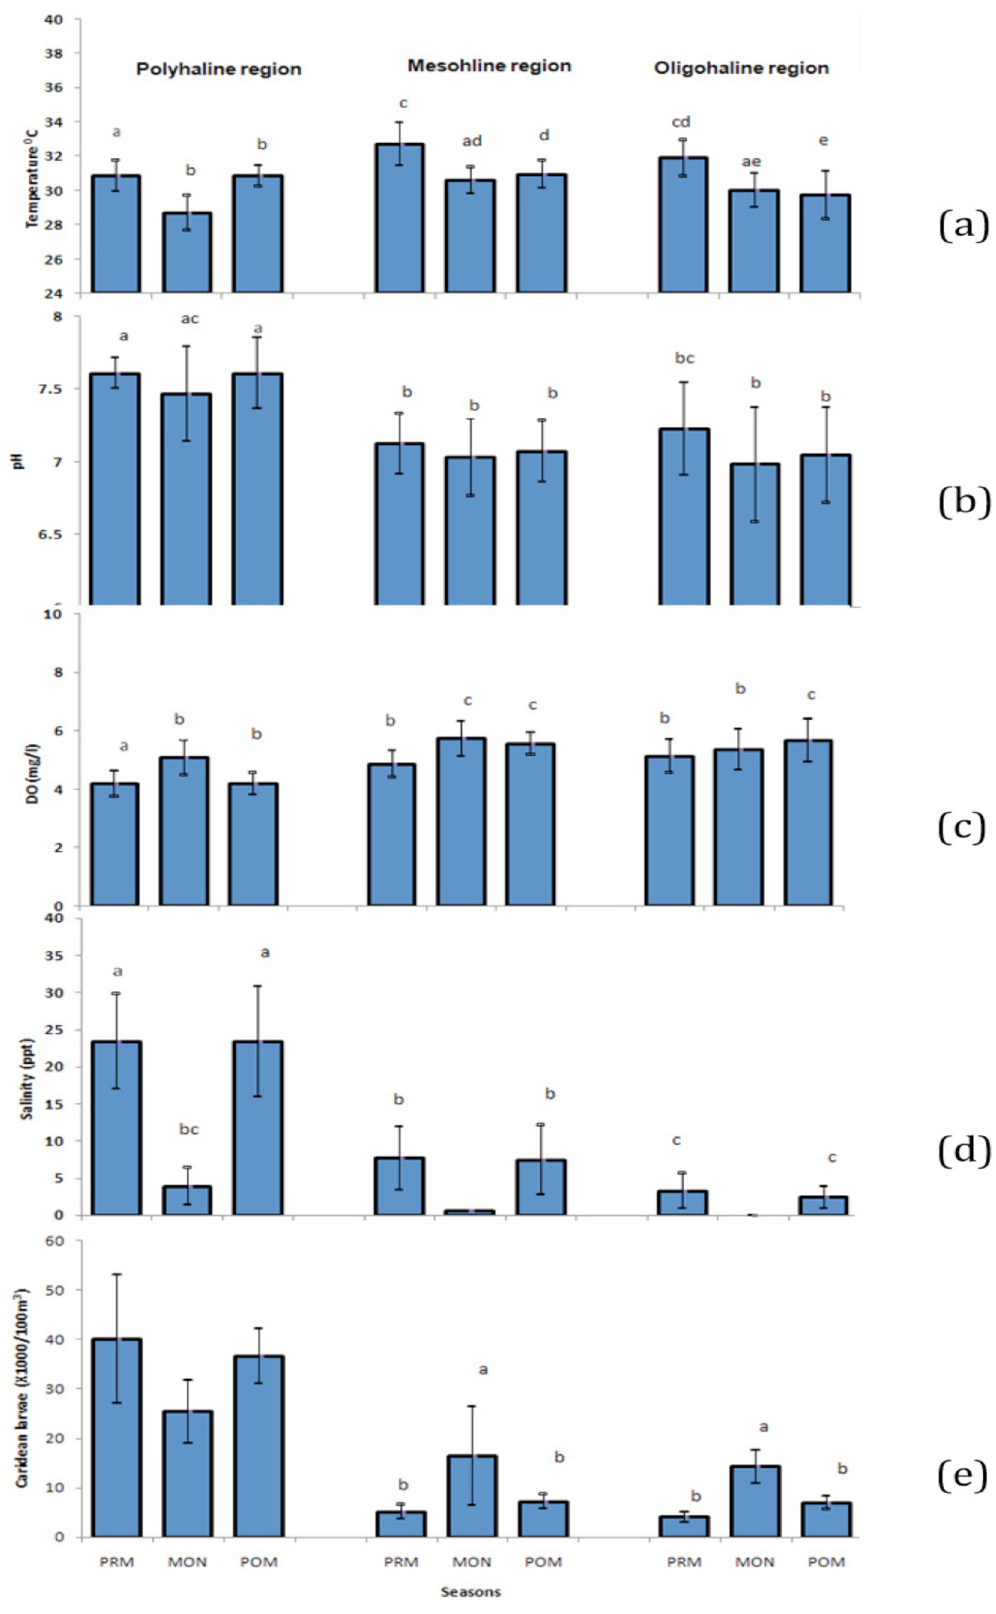
Fig. 3. Mean ±standard error of a: surface water temperature; b: pH; c: salinity; d: dissolved oxygen; and e: caridean larval abundance recorded in premonsoon (PRM), monsoon (MON) and post monsoon (POM) in polyhaline, mesohaline and oligohaline zones in Vembanad lake. Page 5 of